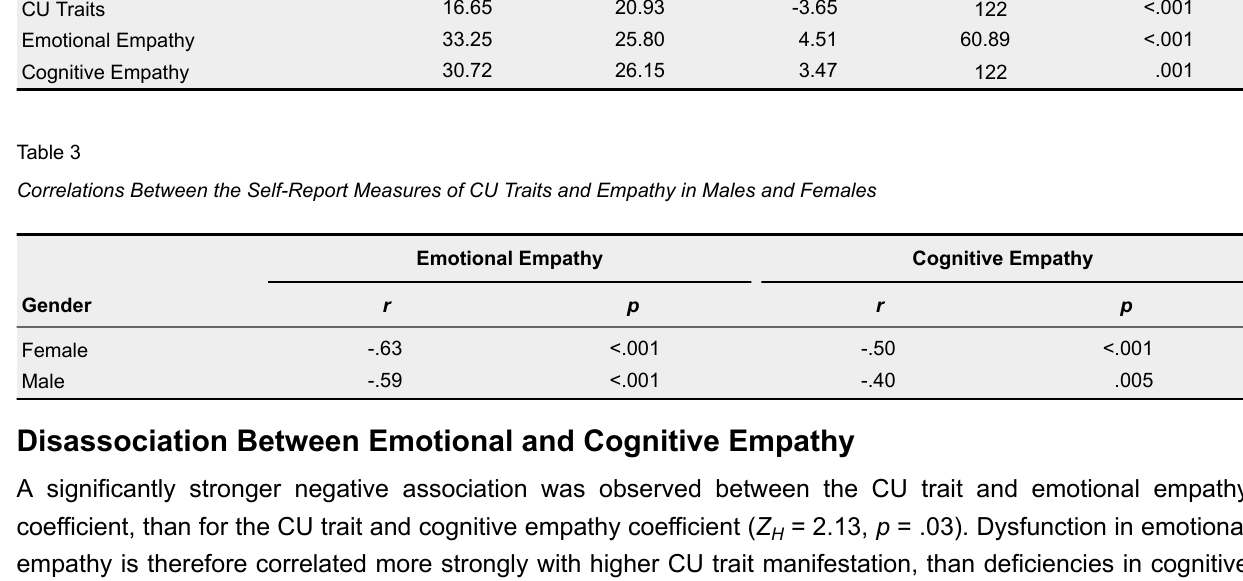
Differences in the Male and Female Scores on the Self-Report Measures of CU Traits and Empathy Mean t-Test for Equality of Means Measure Female Male t df p CU Traits 16.65 20.93 -3.65 122 <.001 Emotional Empathy 33.25 25.80 4.51 60.89 <.001 Cognitive Empathy 30.72 26.15 3.47 122 .001